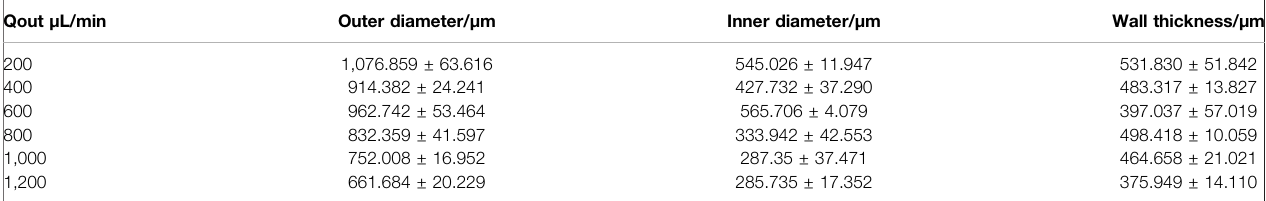
TABLE 2 | Average value of microtubule structure under different outer liquid fl ow